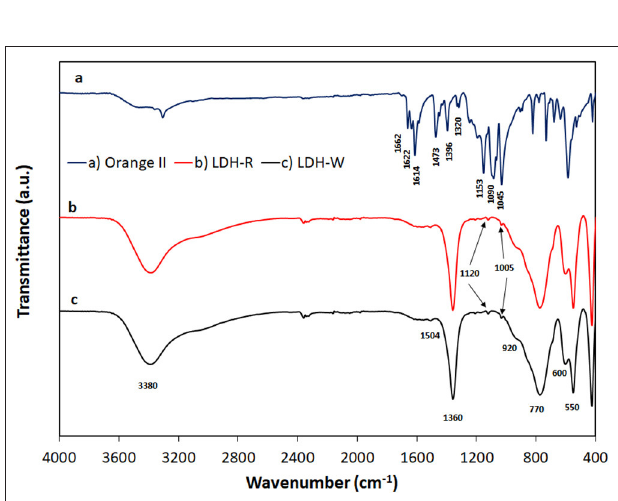
FIGURE 11 | FTIR spectra of (A) Orange II dye; (B) LDH–R after adsorption; (C) LDH–W after adsorption.